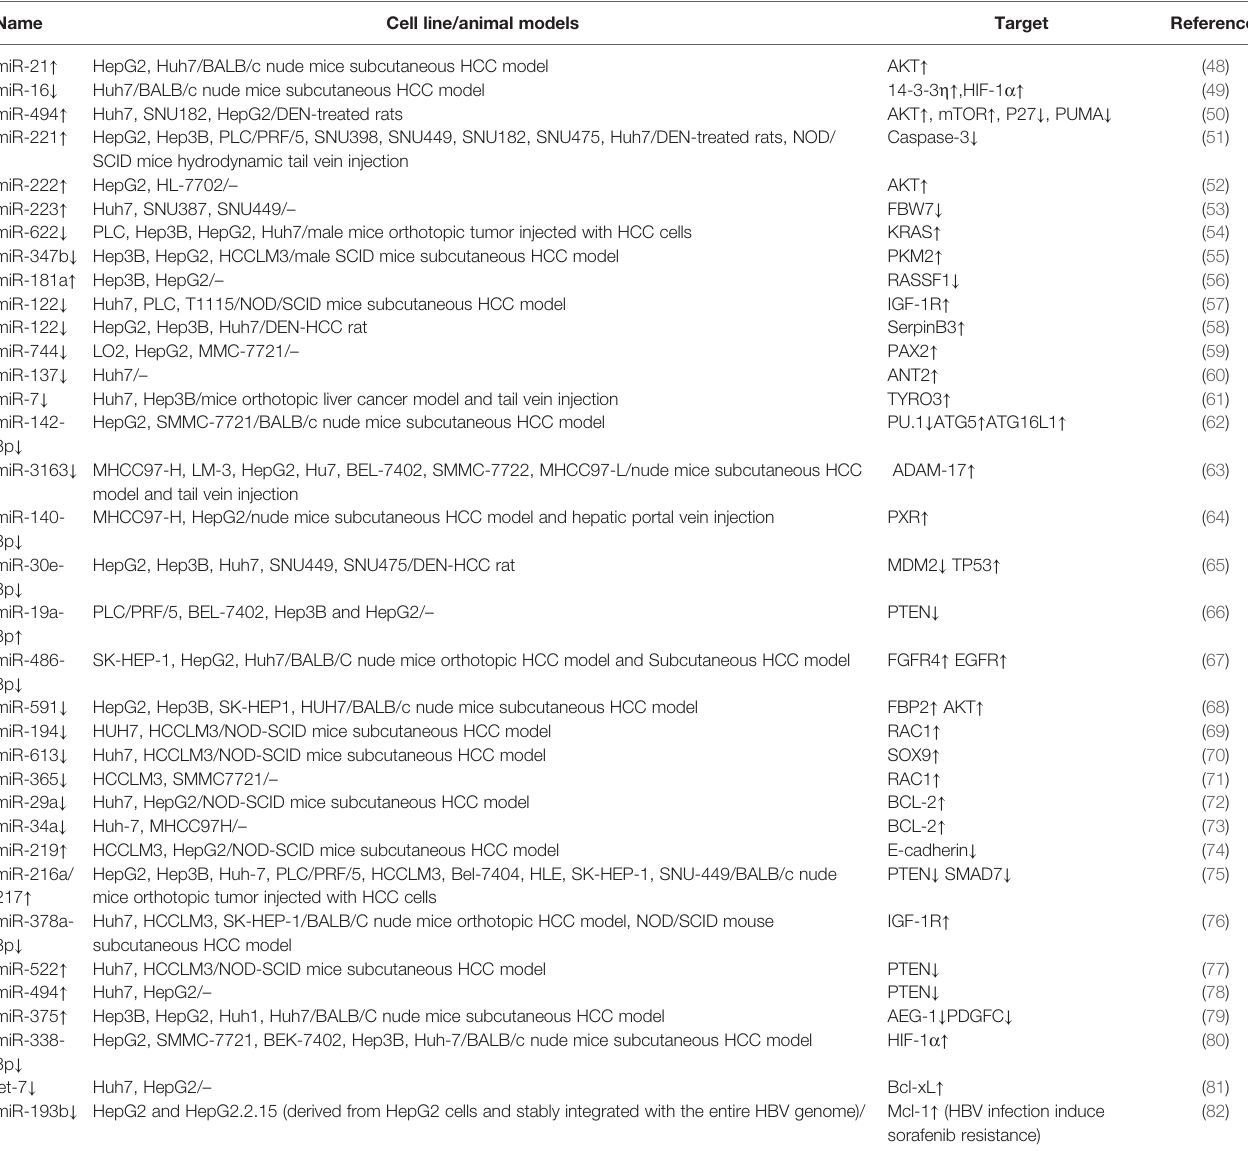
TABLE 1 | miRNA and sorafenib resistance in HCC cells.